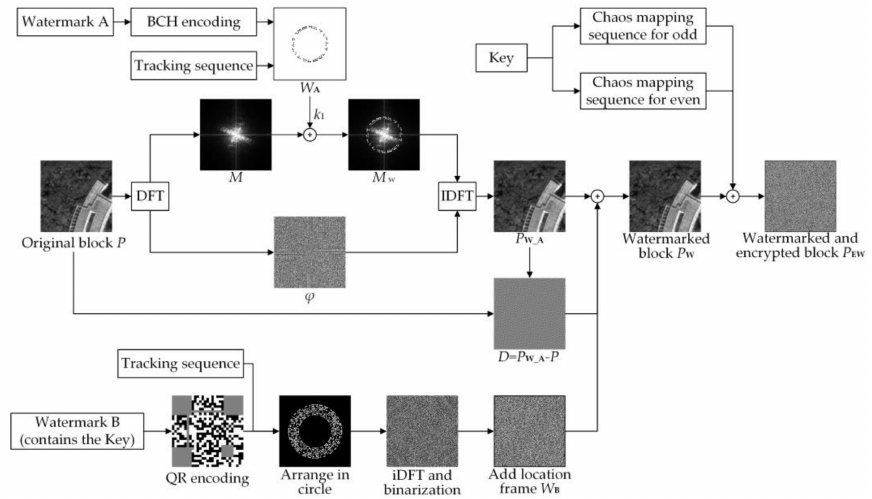
Figure 2. Embedding and encryption process of one